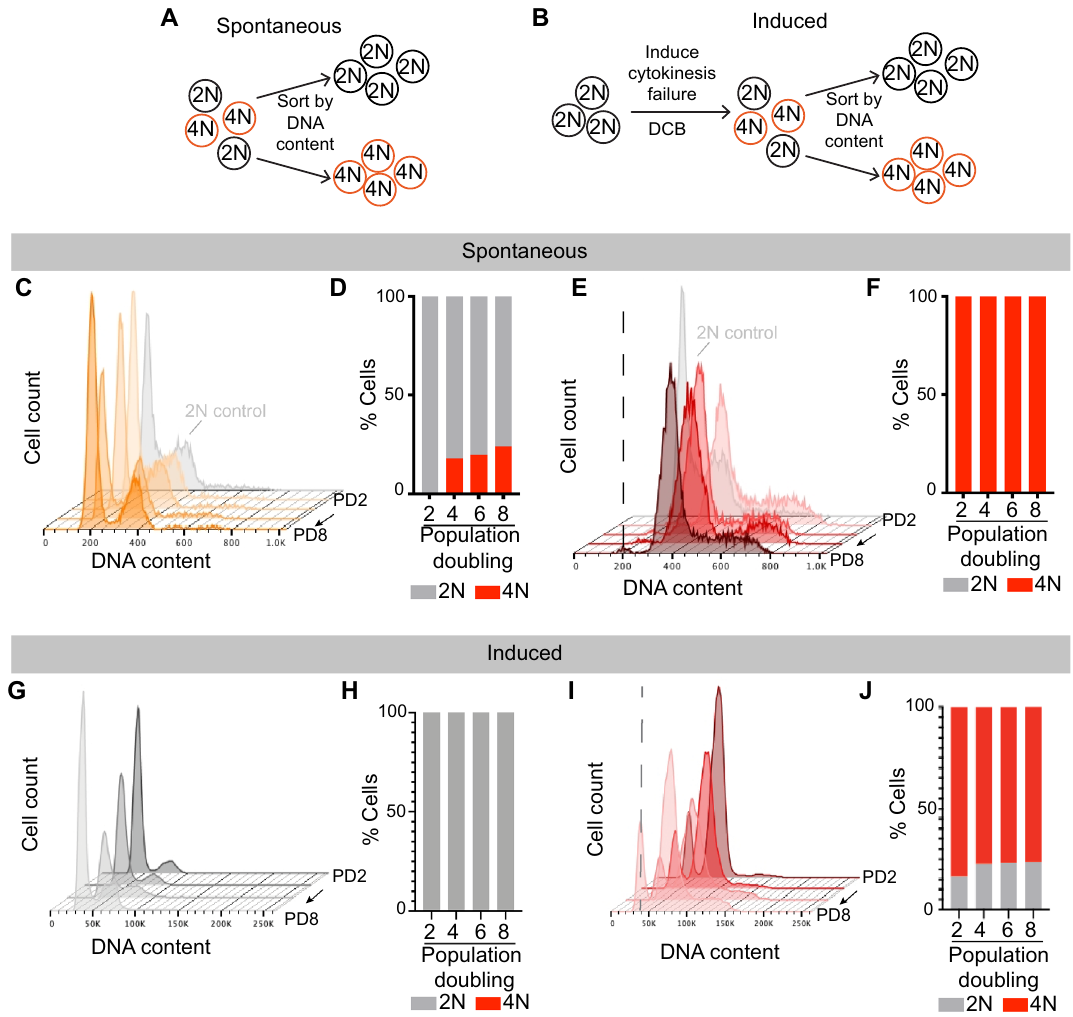
Figure 2. Creation of matched diploid and tetraploid recurrent tumor cell models. ( A ) Schematic outlining the generation of matched diploid and tetraploid populations from a recurrent tumor with spontaneously occurring tetraploid cells. Figure created using Adobe Illustrator (Illustrator CC 2021, version 25.0, https:// www. adobe. com/ produ cts/ illus trator. html). ( B ) Schematic outlining the generation of isogenic diploid and tetraploid recurrent tumor cells following treatment of diploid tumor cell cultures with the cytokinesis inhibitor DCB. Figure created using Adobe Illustrator (Illustrator CC 2021, version 25.0, https:// www. adobe. com/ produ cts/ illus trator. html). ( C ) and ( D ) Stability of tumor cell ploidy in sorted diploid cells from the spontaneous model over increasing passages. Representative DNA content staining is shown in ( C ), and the percentage of diploid and tetraploid cells at each population doubling (PD) is shown in ( D ). ( E ) and ( F ) Stability of tumor cell ploidy in sorted tetraploid cells from the spontaneous model over increasing passages. Representative DNA content staining is shown in ( E ), and the percent of diploid and tetraploid cells at each population doubling is shown in ( F ). Dotted line in ( E ) corresponds to the G1 peak of the 2N control. ( G ) and ( H ) Stability of tumor cell ploidy in sorted diploid cells from the induced model over increasing passages. Representative DNA content staining is shown in ( G ), and the percentage of diploid and tetraploid cells at each population doubling (PD) is shown in ( H ). ( I ) and ( J ) Stability of tumor cell ploidy in sorted tetraploid cells from the induced model over increasing passages. Representative DNA content staining is shown in ( I ), and the percent of diploid and tetraploid cells at each population doubling is shown in ( J ). Dotted line in ( I ) corresponds to the G1 peak of the 2N control. ( D , F , H and J ) were generated using Graph Pad Prism 9 software (version 9.0.0 (86) for Mac, San Diego, California USA, https:// www. graph pad. com/ scien tific- softw are/ prism/). ( C and E ) were generated using FlowJo (FlowJo Software for Mac, Version 10.7.2. Becton, Dickinson and Company;